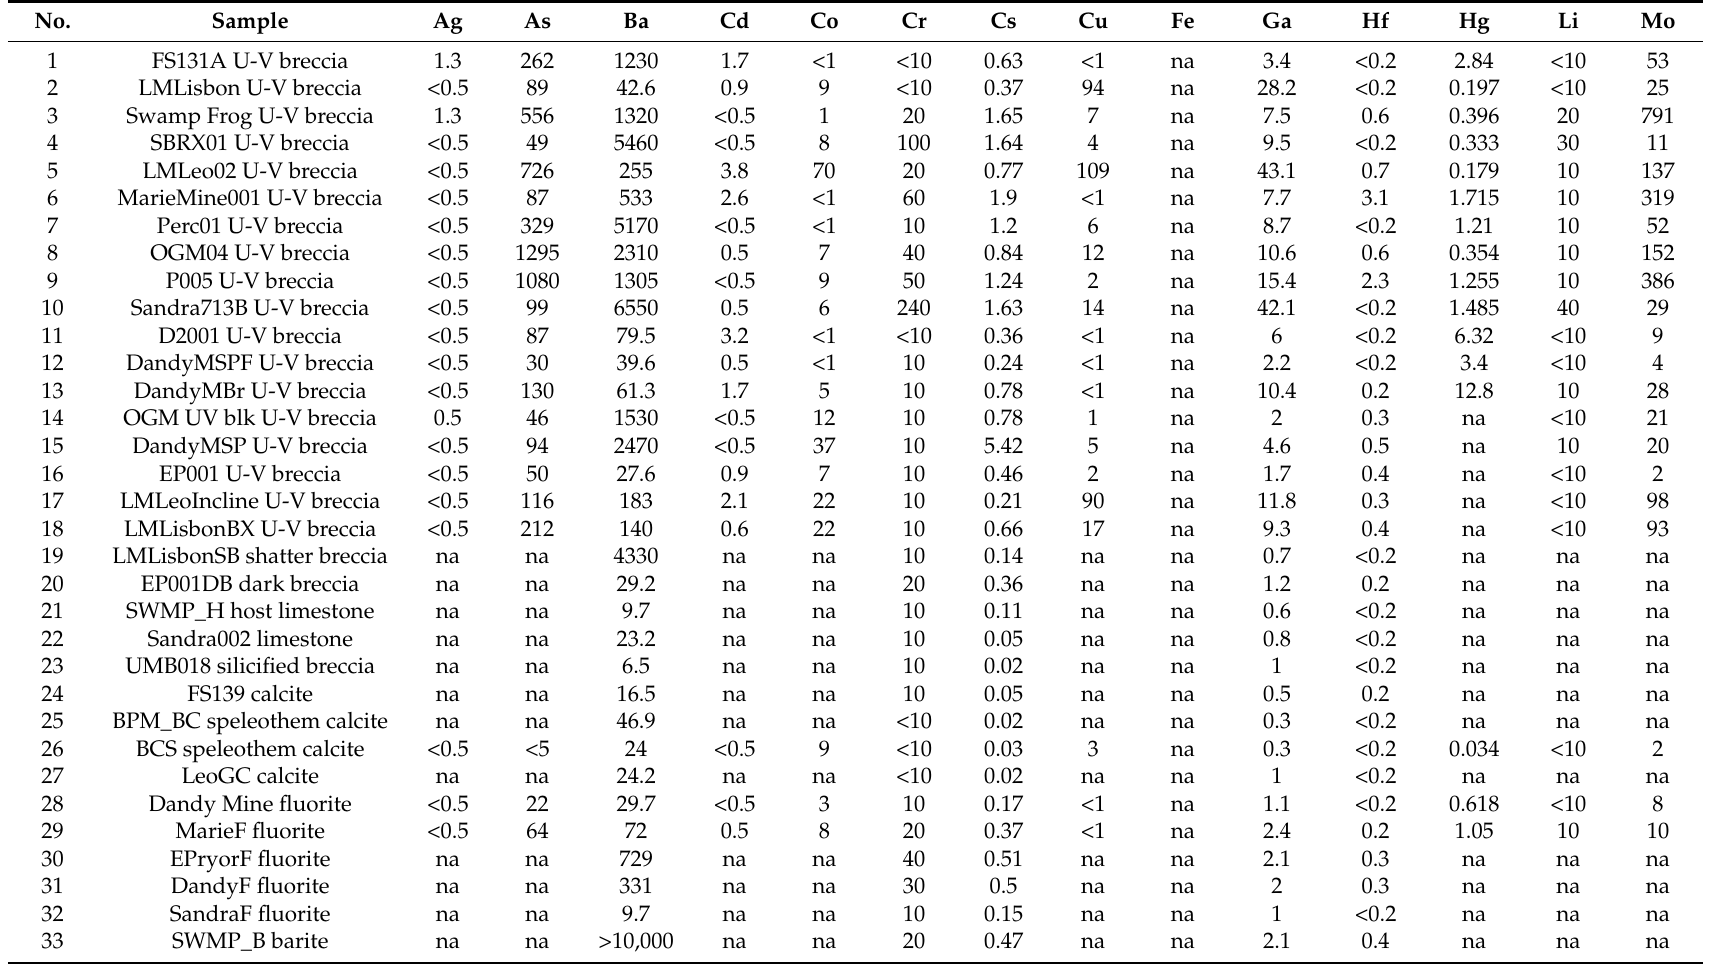
Table A2. Other metals analyzed by ALS laboratory results with samples listed across the top of the table and elements to the left side. The first 18 samples are mineralized breccia samples. The next 23 samples are the host rock, gangue minerals and unmineralized breccia samples. Values with < indicate the value was below the detection limit of the analysis and (na) = not analyzed. Values are in